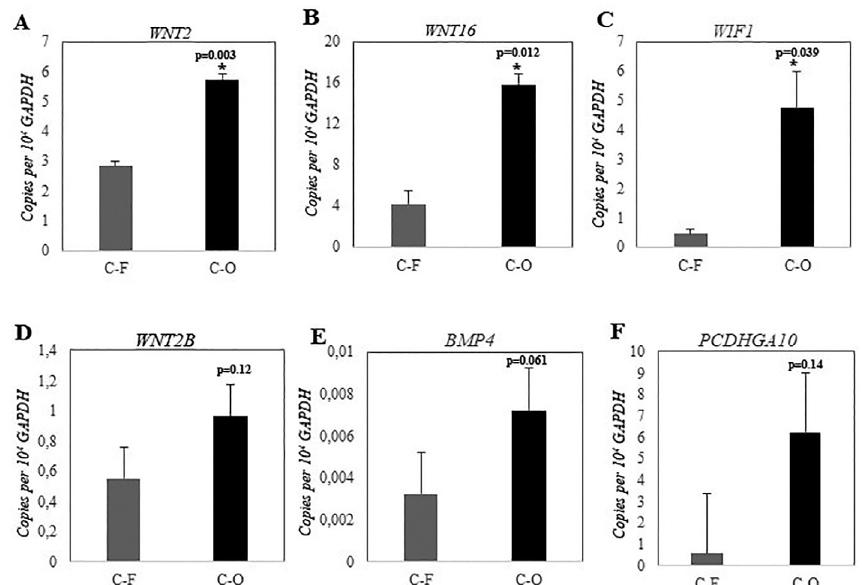
Figure 5- Quantitative reverse transcription-polymerase chain reaction (RT-qPCR) showed that the expression of WNT2 (A), WNT16 (B) and WIF1 (C) was significantly higher in C-O clones than in C-F clones. The expression of WNT2B (D), PCDHGA10 (E) and BMP4 (F) was not statistically significantly up-regulated in C-O clones. Bars represent mean ± standard deviation (SD) of three independent experiments. *Statistical significance intergroup was determined using t-test